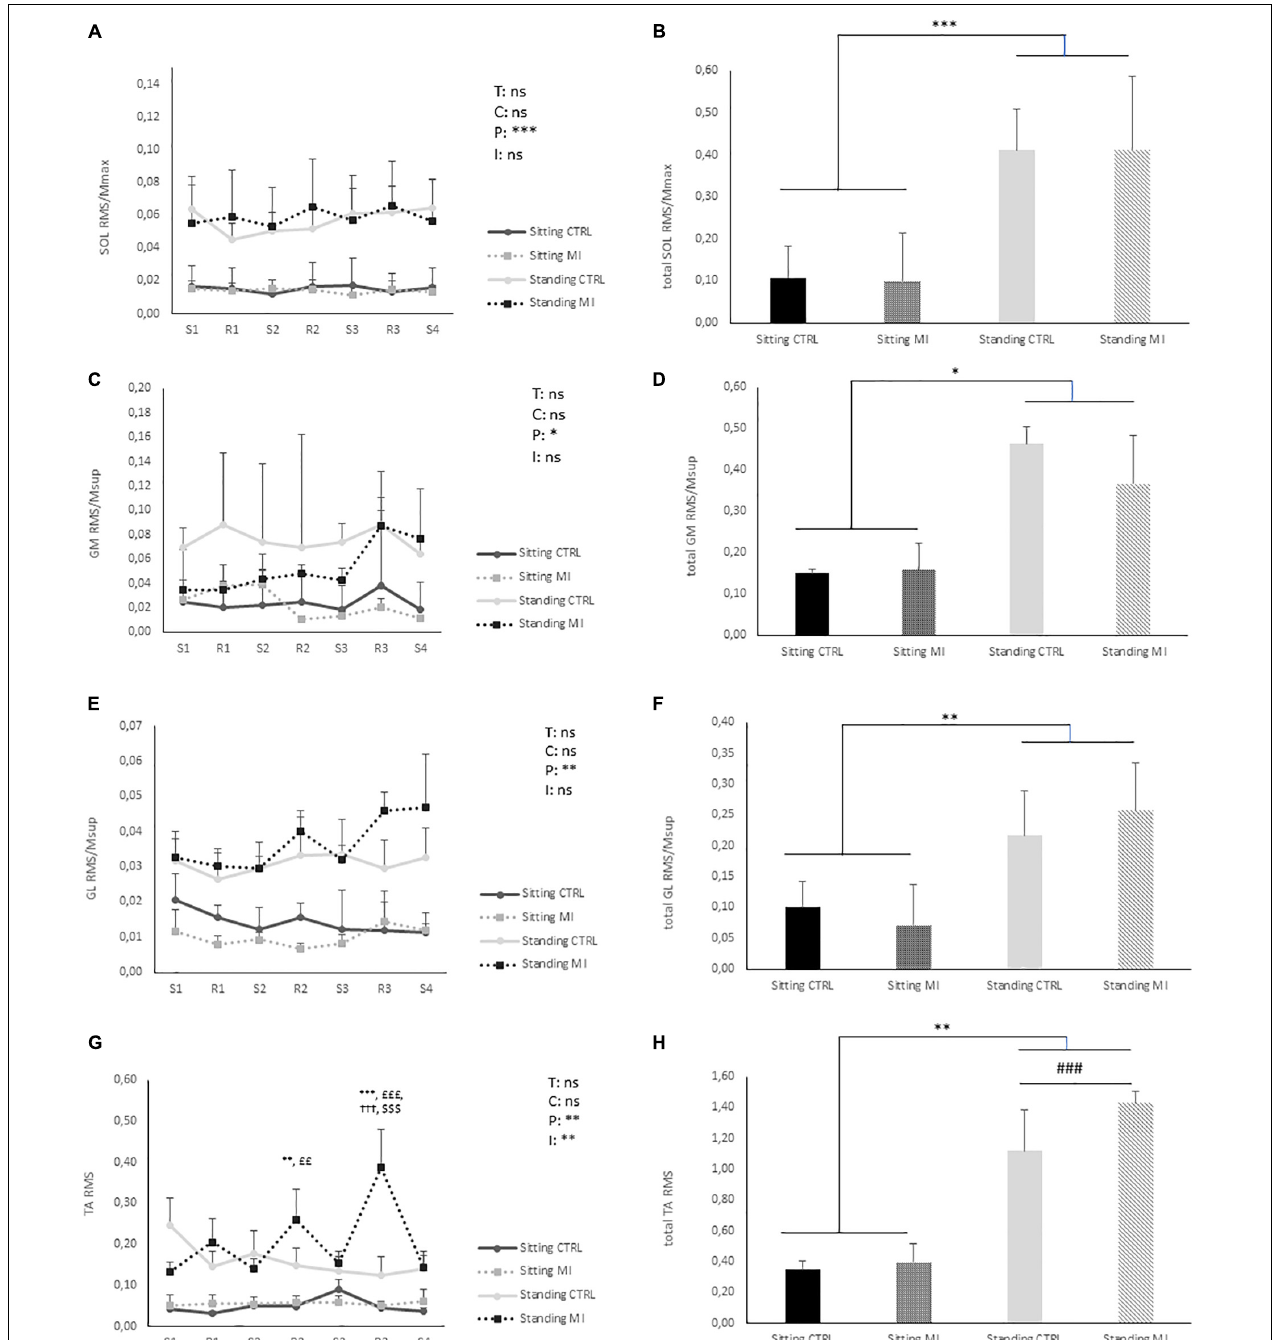
FIGURE 2 | Myoelectrical recordings of leg muscles in standing and sitting postures. The root mean square (RMS) of electromyographic (EMG) activities were calculated for soleus (SOL), Gastrocnemius Medialis (GM), Gastrocnemius Lateralis (GL), and Tibialis Anterior (TA) in MI conditions (right panels) and in CTRL conditions (left panel). For SOL, GM, and GL, RMS is normalized by the maximal M-wave recorded in corresponding condition at PRE (RMS/M MAX ). The RMS of the EMG recorded continuously during the 15-min conditions was spitted in seven parts: during the four series of MI (S1, S2, S3, and S4) and during the three rest periods (R1, R2, and R3). In the CTRL conditions the same cutting was applied. (A) Kinetic of SOL RMS/M MAX . (B) SOL RMS/M MAX value of the entire session. (C) Kinetic of GM RMS/M MAX . (D) GM RMS/M MAX value of the entire session. (E) Kinetic of GL RMS/M MAX . (F) GL RMS/M MAX value of the entire session. (G) Kinetic of TA RMS. (H) TA RMS value of the entire session. T: time effect; C: condition effect; P: position effect; I: interaction effect between “time,” “condition,” and “posture”; ns: non-significant. ###: significantly different from sitting at p < 0.001. ∗ , ∗∗ , ∗∗∗ : significantly different from sitting CTRL at p < 0.05, p < 0.01, and p < 0.001, respectively. ϮϮϮ : significantly different from standing CTRL at p < 0.001. ££, £££: significantly different from sitting MI at p < 0.01 and p < 0.001, respectively. $$$: significantly different from other points of standing MI at p < 0.001.